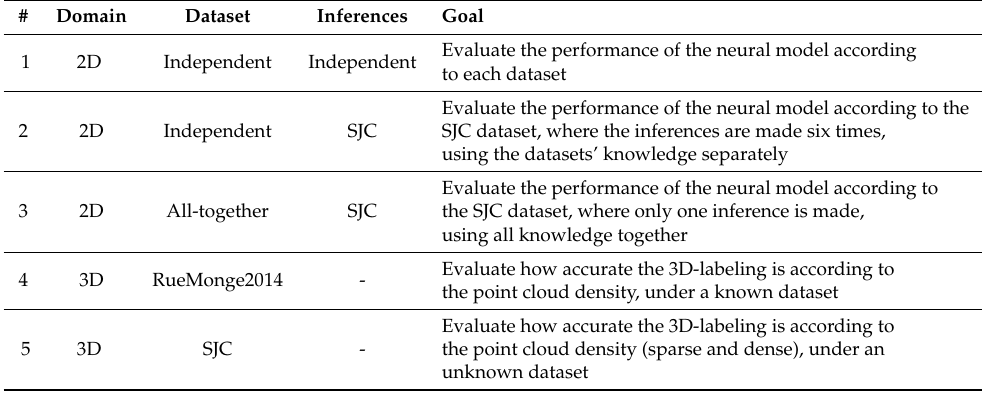
Table 3. Experiments performed in this work. The term “independent” means the dataset or inference was made using only one dataset for training or